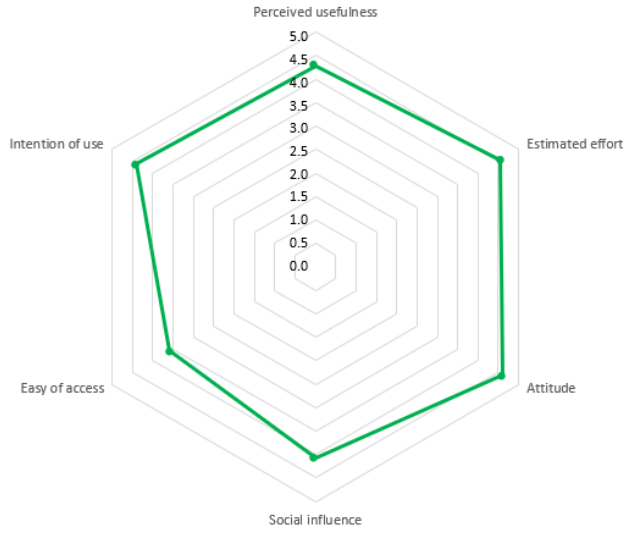
Figure 11. Evaluated